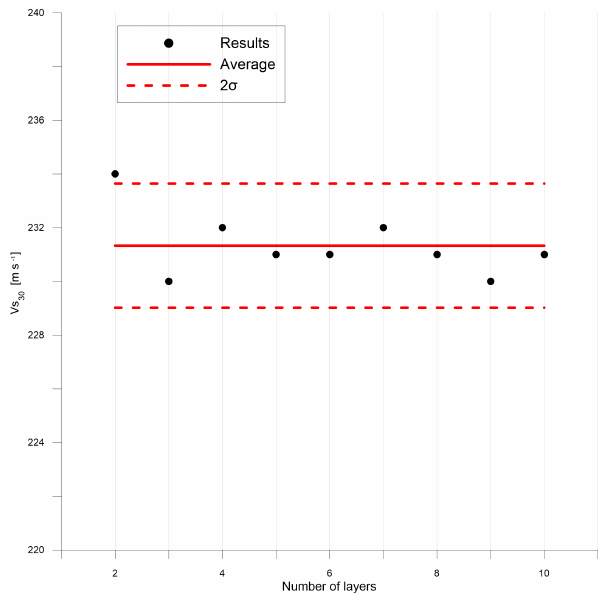
Figure 7. V s as a function of a number of layers (example from 30 Beit Alfa).